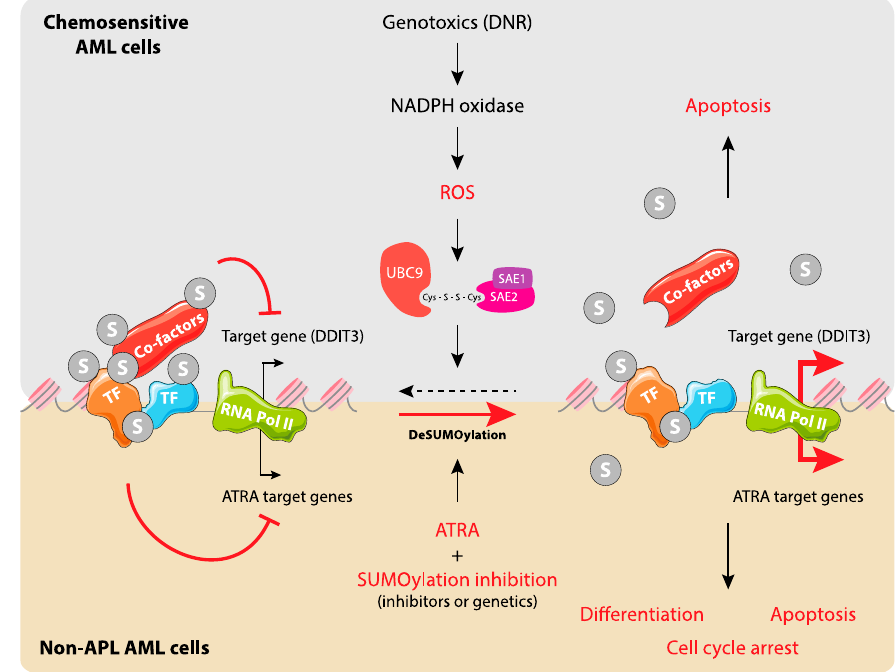
Figure 3. SUMOylation regulates gene expression during Acute Myeloid Leukemia (AML)